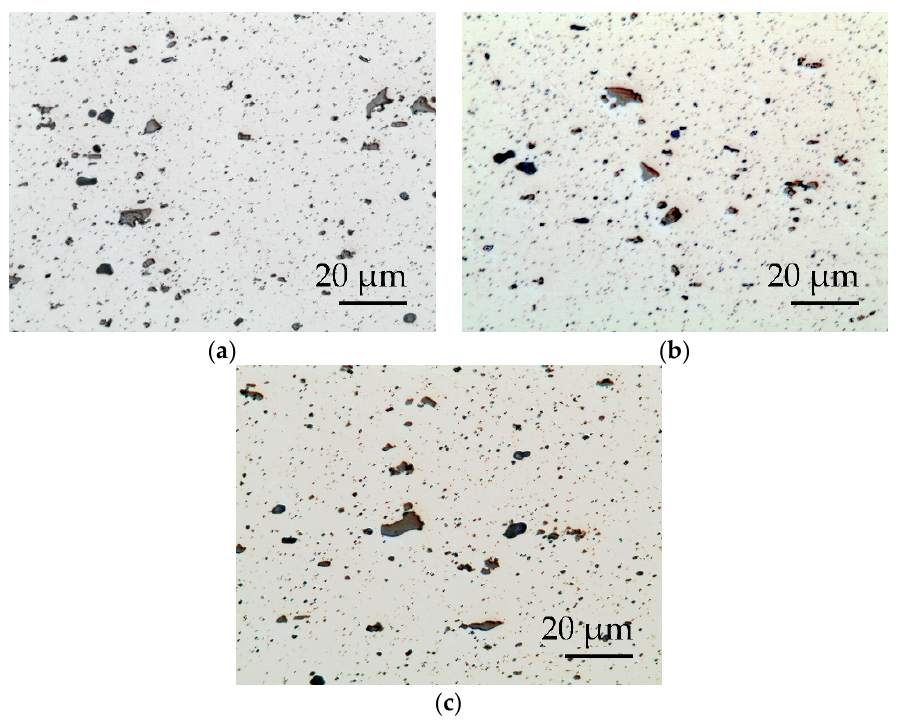
Figure 7. EN-AW5754 metallographic images obtained with colloidal silica polishing up to 0.25 µm, lightly attacked with hydrofluoric acid: ( a ) after PFA coating, ( b ) after Quanta laser decoating, ( c ) after SPI laser decoating.